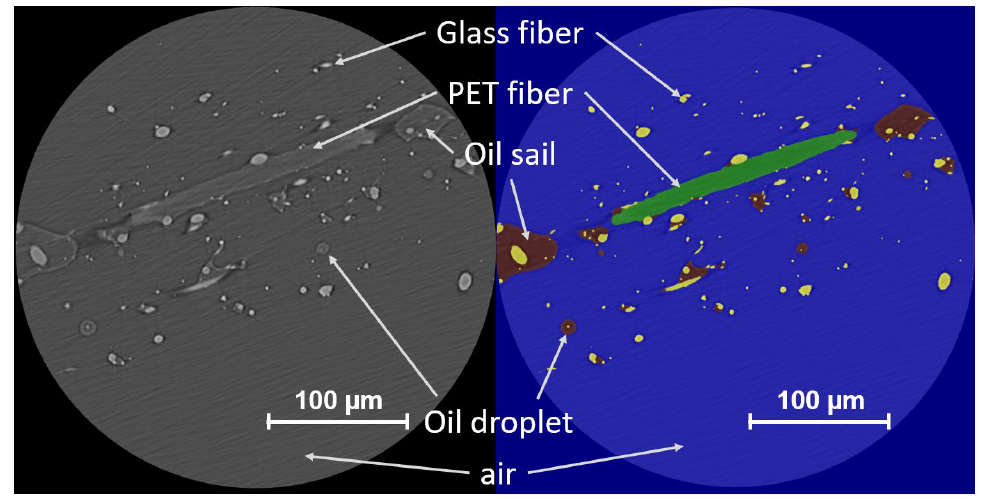
Figure 7. Left : 2D grey scale map of slice 1021/1911. Right : Segmented slice 1021 using the deep learning tool of Dragonfly (Object Research Systems (ORS) Inc., Montreal, Canada). Micro glass fibers are marked in yellow, PET fibers in green, oil structures as oil sails or droplets in brown and air in blue color.